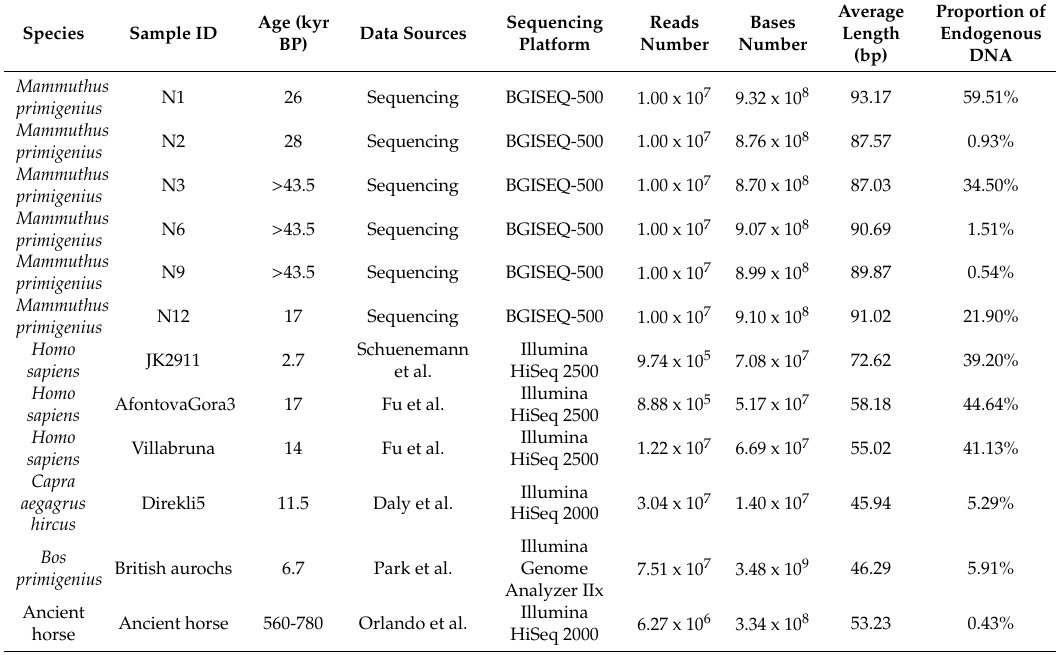
Table 1. The description of the next-generation sequencing (NGS) data and